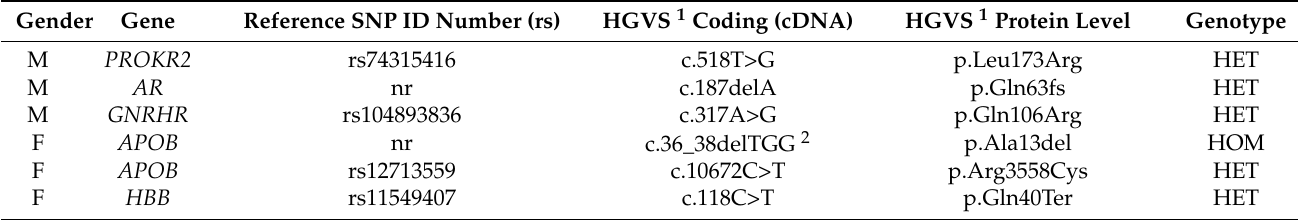
Table 1. Pathogenic variants identified in the Training and/or Validation set in genes different from those originally analyzed by traditional diagnostic methods.